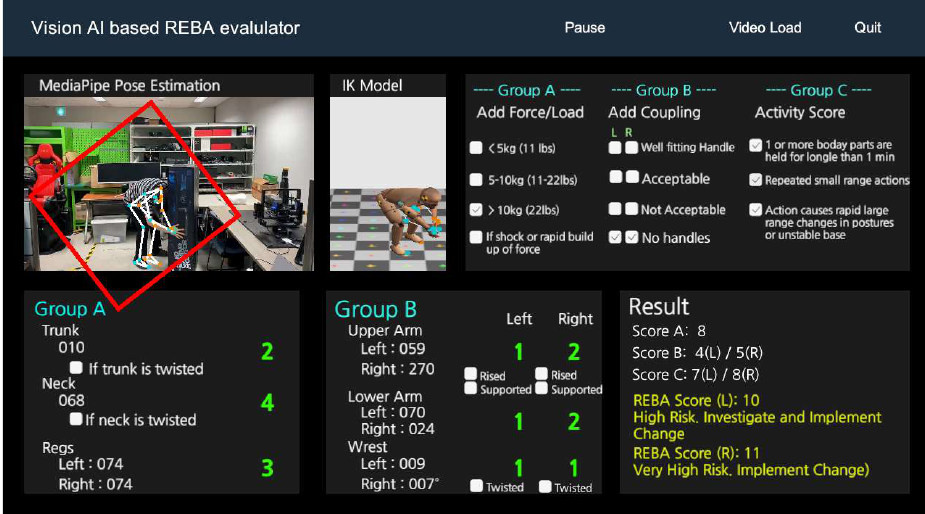
Figure 34. Evaluation of the posture for heavy load work.